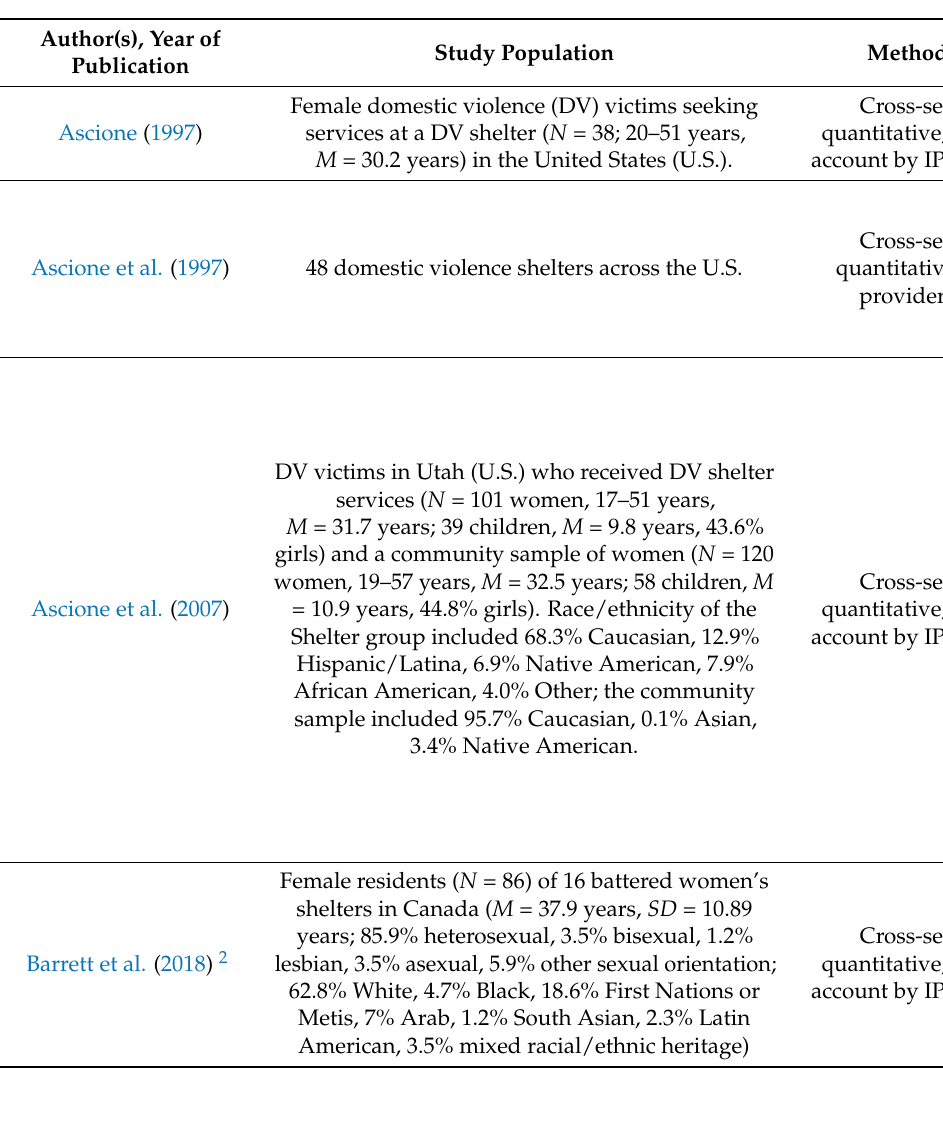
Table 3. Studies Included in the Scoping Review That Examined Intimate Partner Violence and Animal